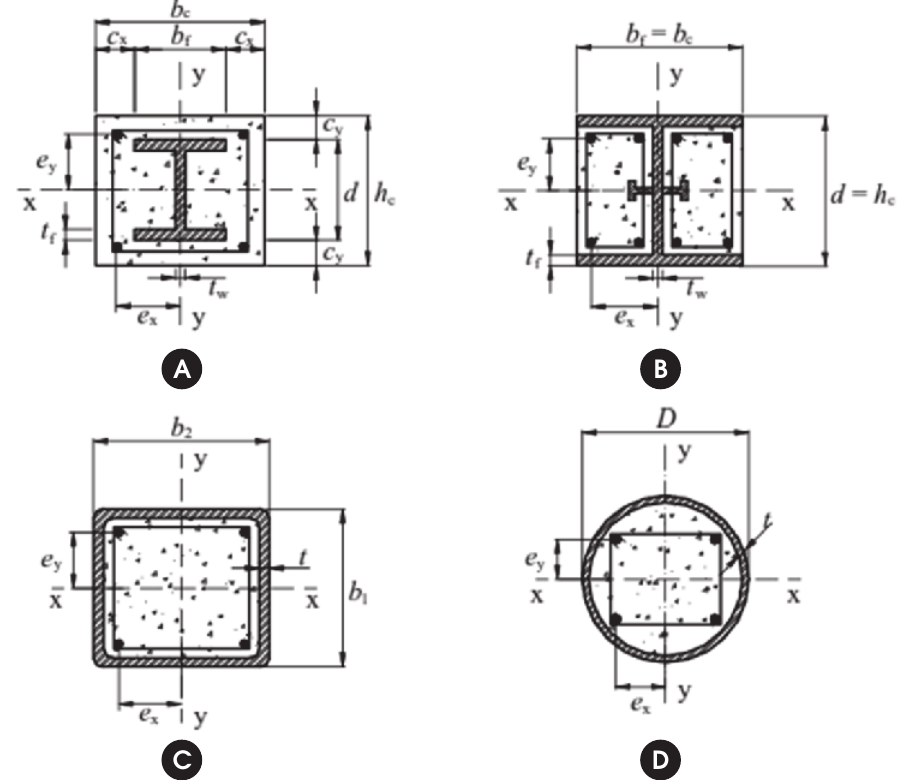
Types of cross-sections of composite columns. Source: